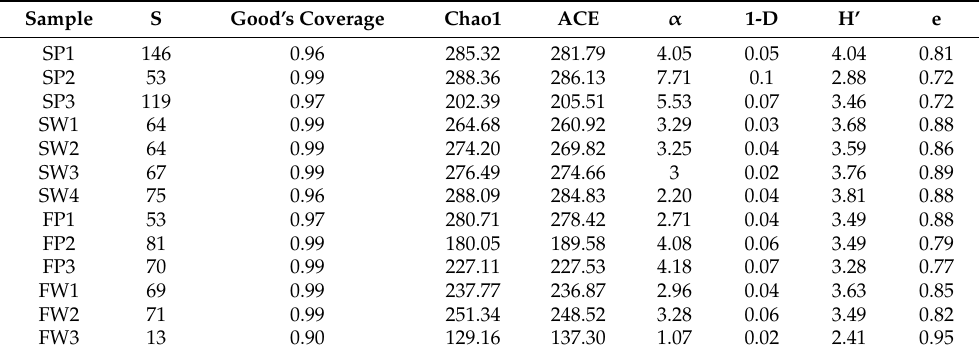
Table 4. Diversity indexes of the studied samples. S is the total number of families; Chao1 and ACE are abundance-based richness estimators; α is the alpha diversity; 1-D is the Simpson’s index; H’ is the Shannon–Wiener diversity; e is the evenness. Sample